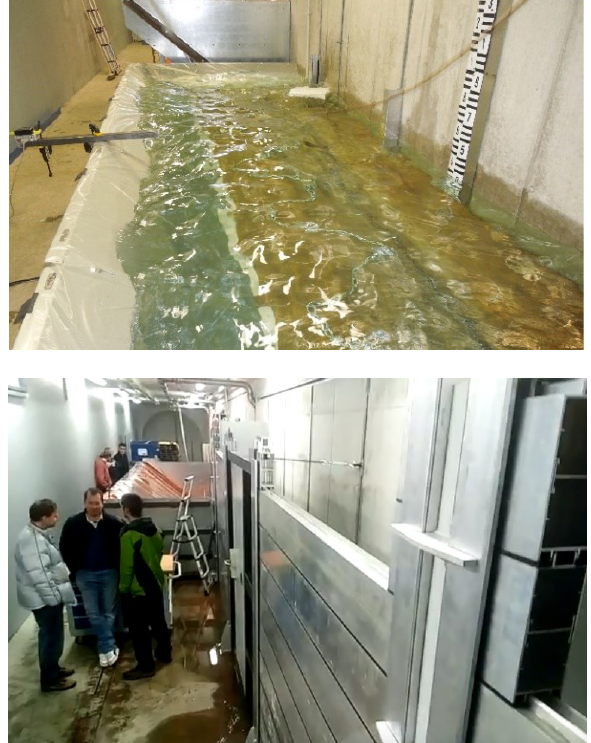
Fig. 1 . Experimental testing of hydrostatic and hydrodynamic loads in the water channel (above), preparation of tests for the installation of mobile anti-flood board